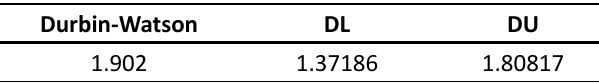
Table 6: Autocorrelation Test Result